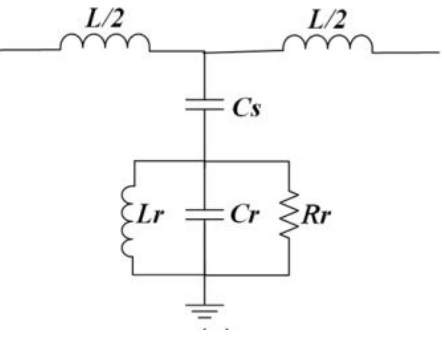
Figure 6. Equivalent circuit of CSRR. Table 2. Parametric analysis of the proposed sensor.